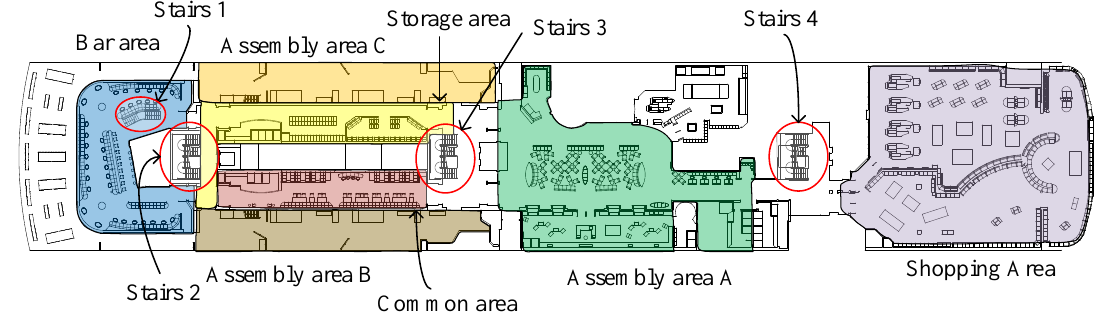
Figure 1. The construction diagram of the first layer.